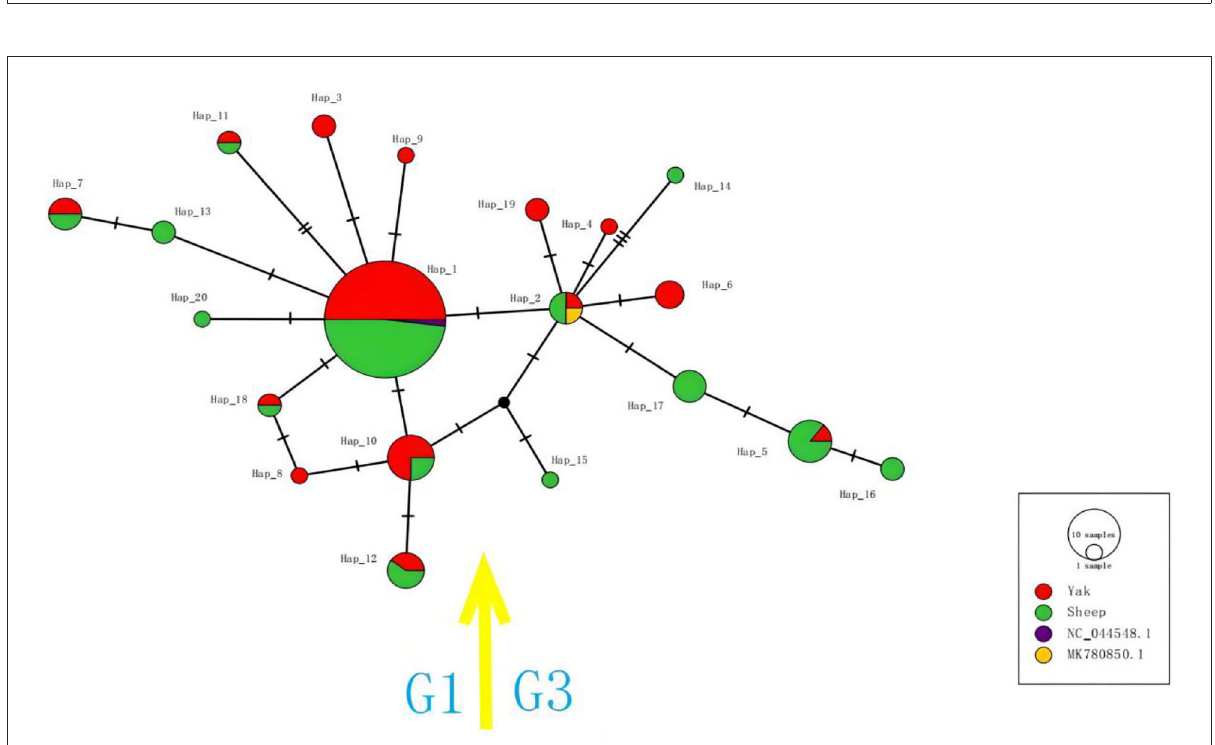
FIGURE3 The haplotype network for the cox 1 gene of E. granulosus s.s. Circle sizes are proportional to the frequency of each haplotype. The number of mutations separating haplotypes is indicated by dash marks. Hap: